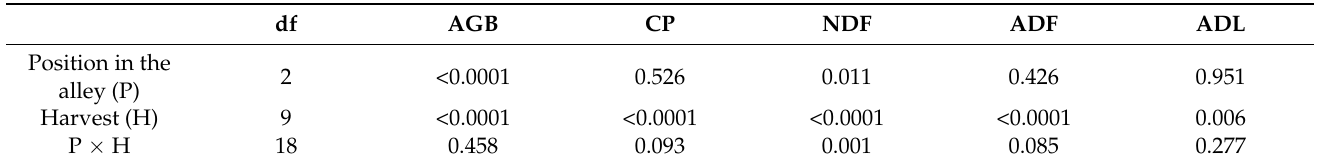
Table 1. p values of the fixed effects, position and harvest, and their interaction on the under-canopy alfalfa on the above- ground biomass production (AGB), the crude protein (CP), the neutral detergent fibre content (NDF), the acid detergent fibre content (ADF), and the acid detergent lignin (ADL) content.